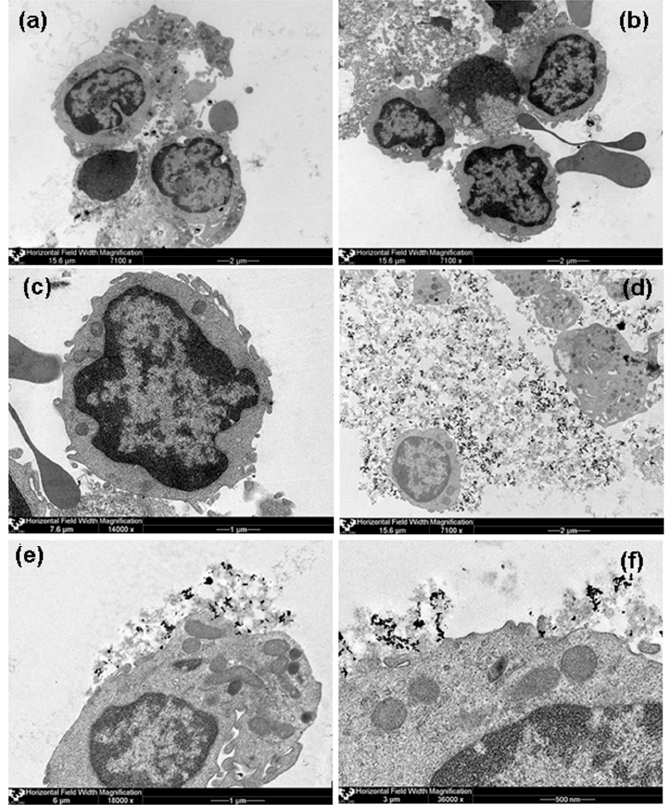
Figure 7. TEM of HBMLs mononuclear blood leukocytes. ( a )—control culture grown without MNPs. HBMLs mononuclear blood leukocytes after 24-h contact with MNPs of suspension of iron oxide MNPs without chitosan (FF1) at a dose of 100 MTDs: ( b )—magnification ×7100, ( c )—magnification ×14,000. HBMLs after 24-h contact with MNPs of suspension of iron oxide MNPs with chitosan (FF2) at a dose of 100 MTDs, magnifications: ( d )—×7100, ( e )—×18000, ( f )—×36000.